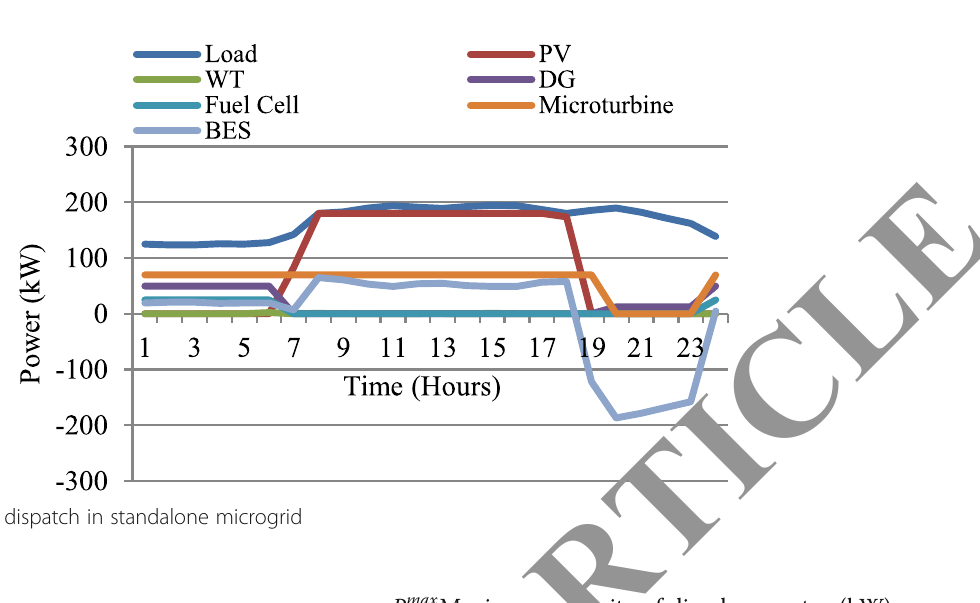
Fig. 12 Optimal power dispatch in standalone microgrid